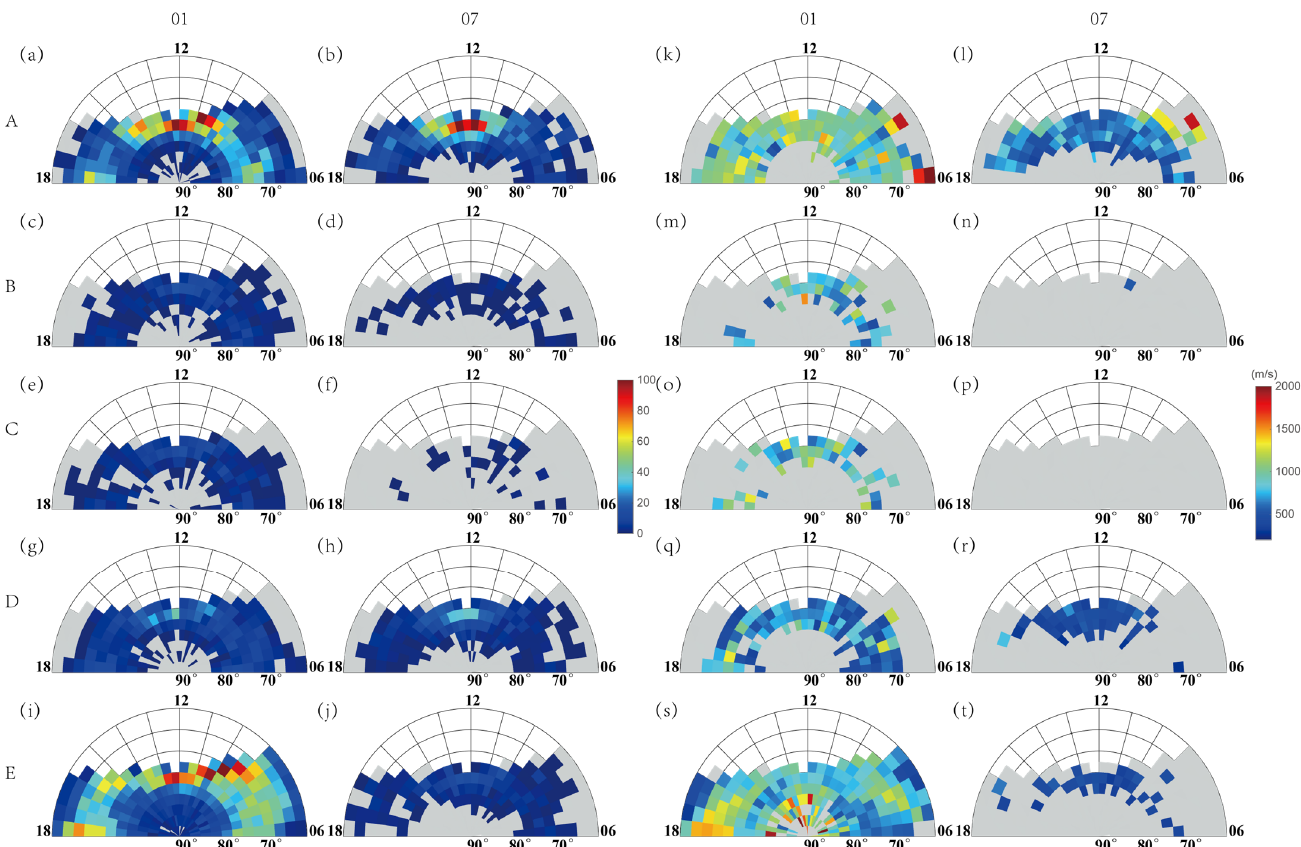
Figure 8. The distribution and velocities for different types of ion upflows in January/July in MLT/MLAT coordinate. From top to bottom are ion upflows of type A to E, respectively. ( a – j ) Total events for each month and type, ( k – t ) average velocities in different month and type.